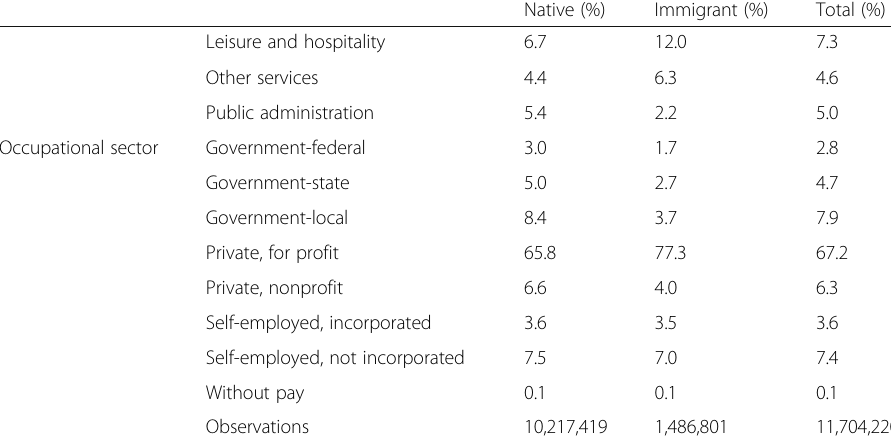
Table 1 Sample composition by immigrant status, CPS data, 1996 – 2013